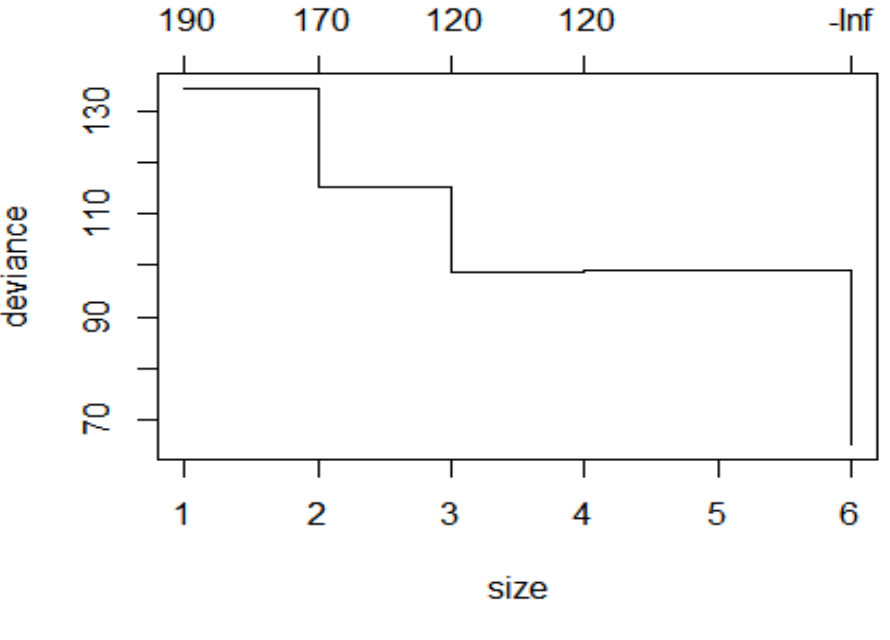
Figure 1. Deviance vs. Tree